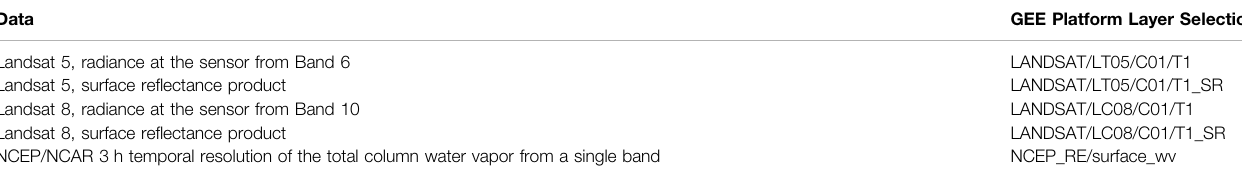
TABLE 2 | Google Earth Engine (GEE)-related data platform